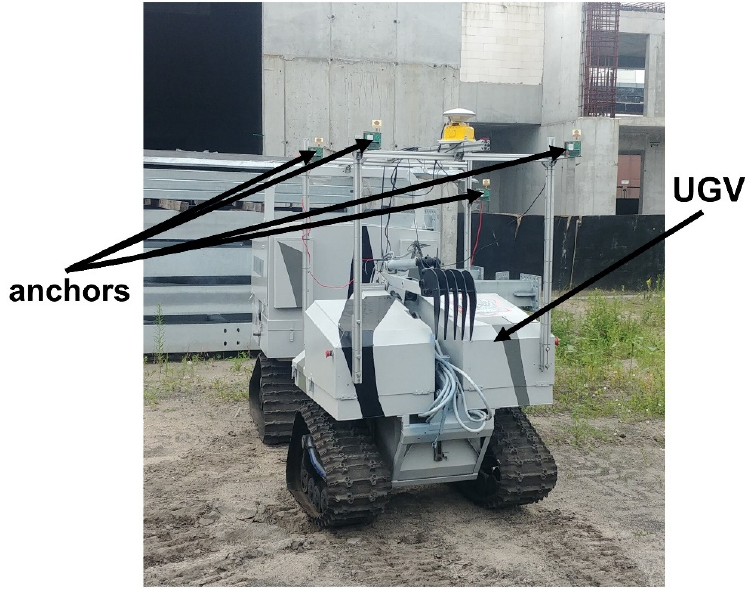
Figure 2. Configuration of UWB modules on a UGV.